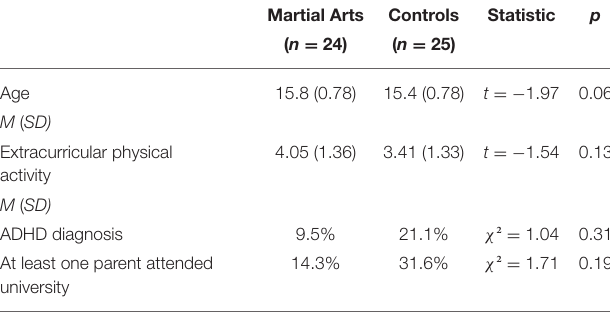
TABLE 1 | Participant characteristics.